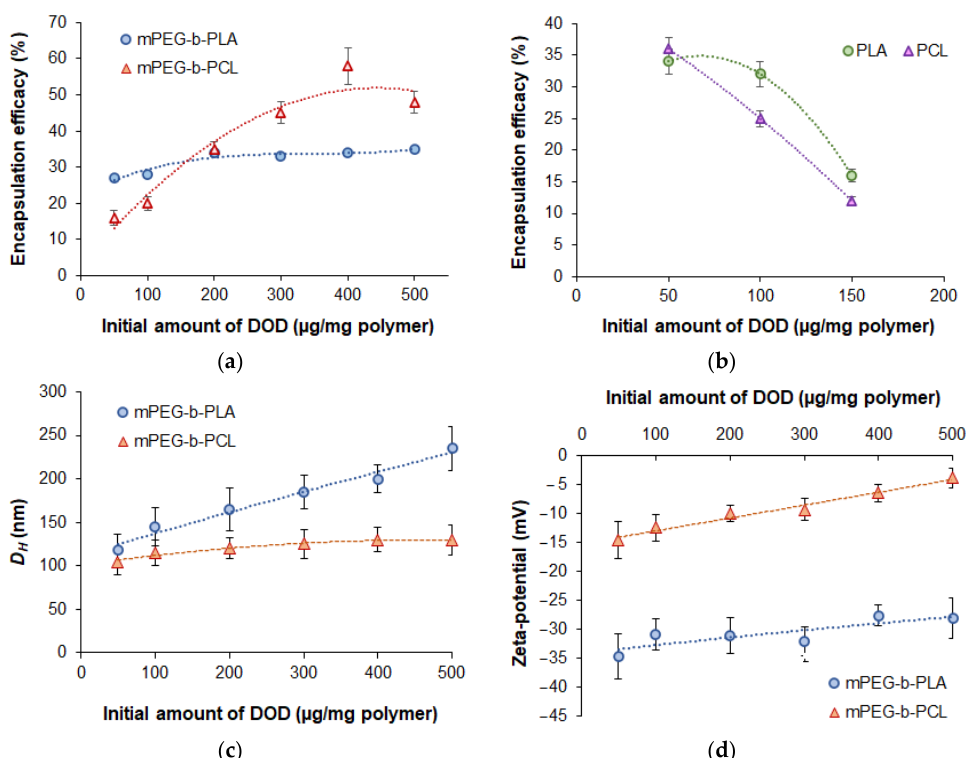
Figure 5. Dependence of the different characteristics of nanomedicines on the initial amount of DOD in the system: encapsulation efficacy for nanoformulations based on mPEG- b -PLA/mPEG- b -PCL ( a ) and PLA/PCL ( b ), in relation to hydrodynamic diameter ( c ), and in terms of ζ -potential ( d ). Characteristics of polymers and empty nanoparticles are provided in Table